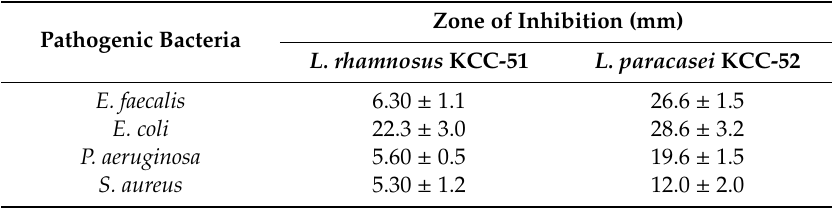
Table 1. Antibacterial activity of extracellular supernatant (ECS) of KCC-51 and KCC-52 against various pathogens by well diffusion method.